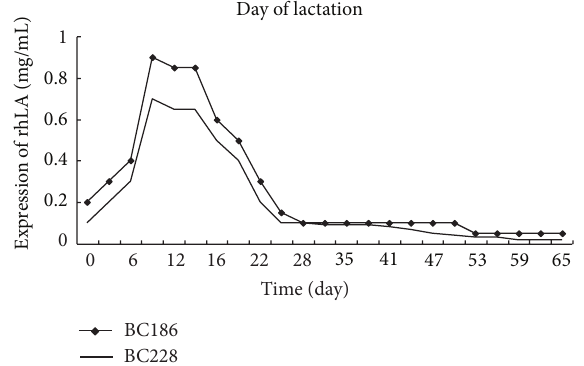
Figure 4: Production of human alpha-lactalbumin in transgenic goat milk during a 65 d lactation.